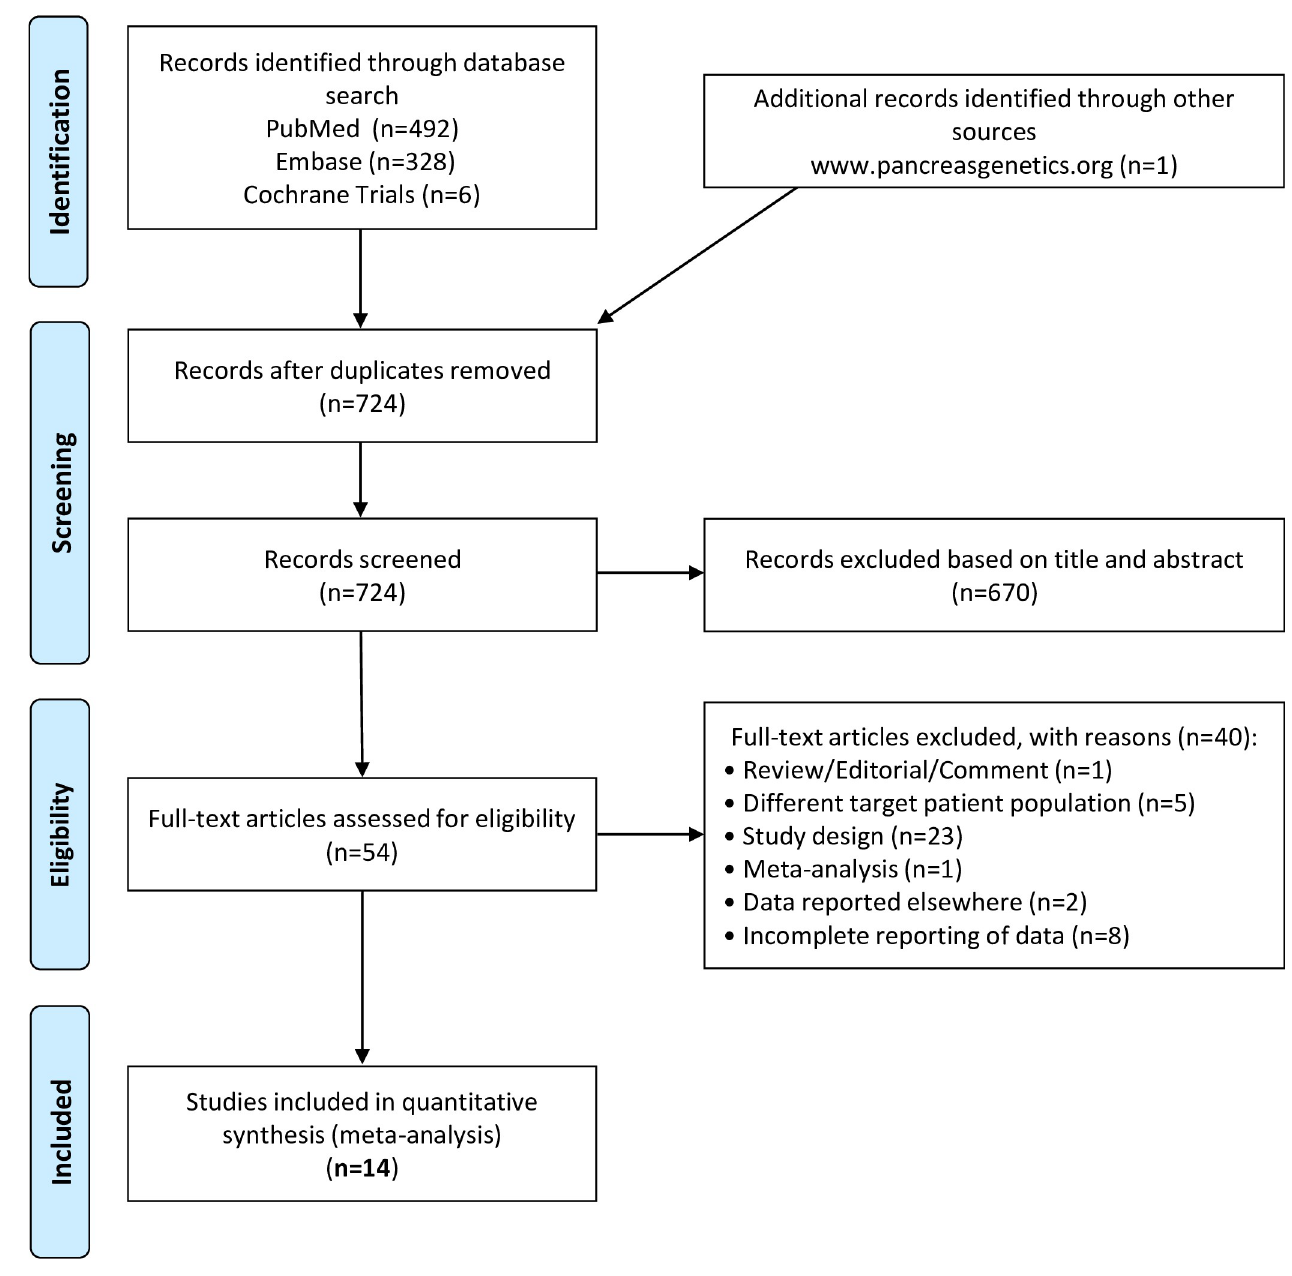
Fig 1. PRISMA flow diagram showing the systematic search and selection